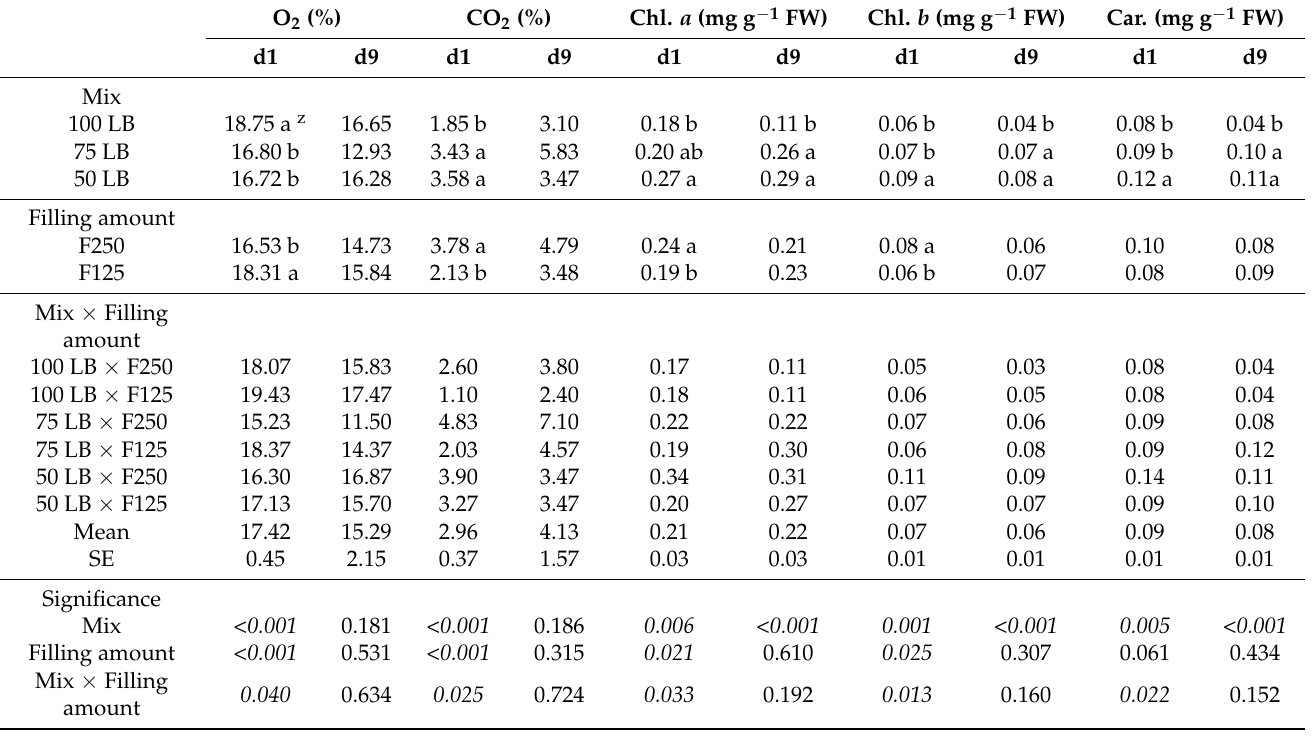
Table 1. Gas composition in the headspace of the bags and pigment content of the fresh-cut baby leaf lettuce and rocket during